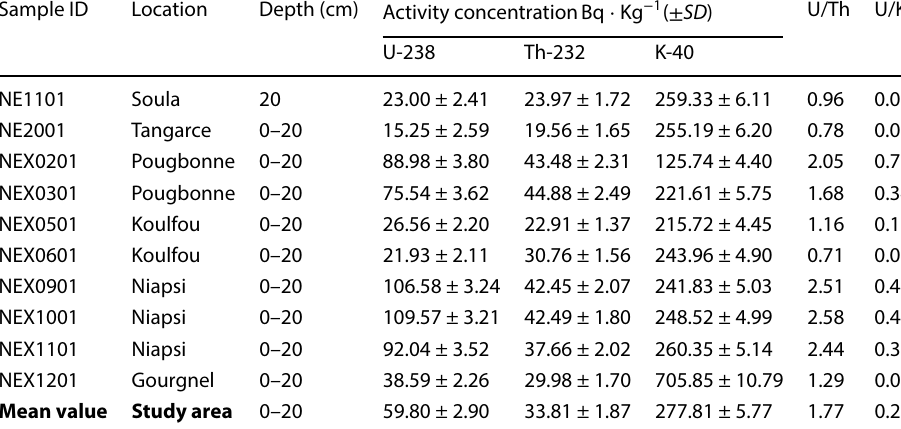
Table 2 Specific activity concentration of 238 U , 232 Th and 40 K in soil samples from Northeastern Burkina